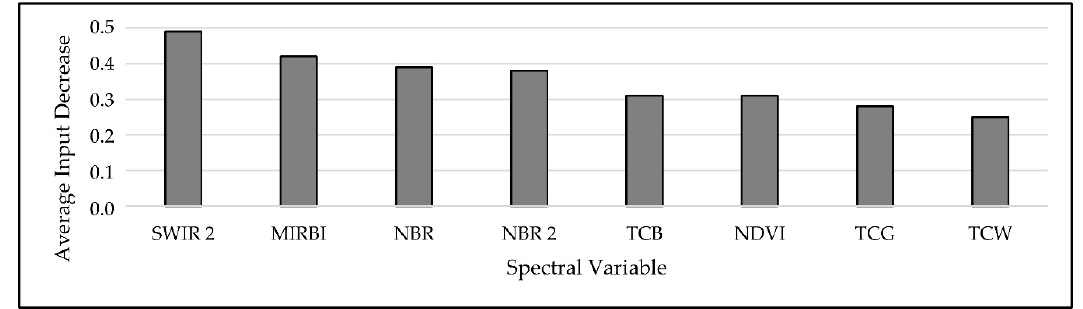
Figure 6. Importance of spectral variables in the Random Forest change detection.